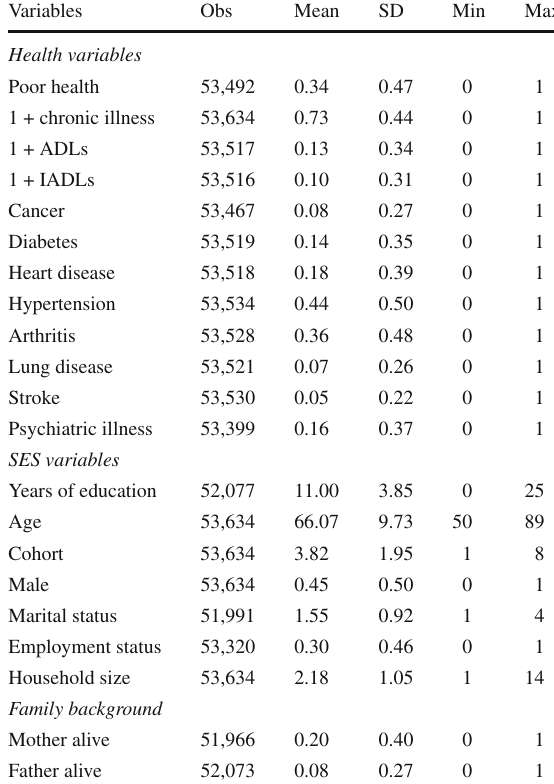
Table 1 Summary